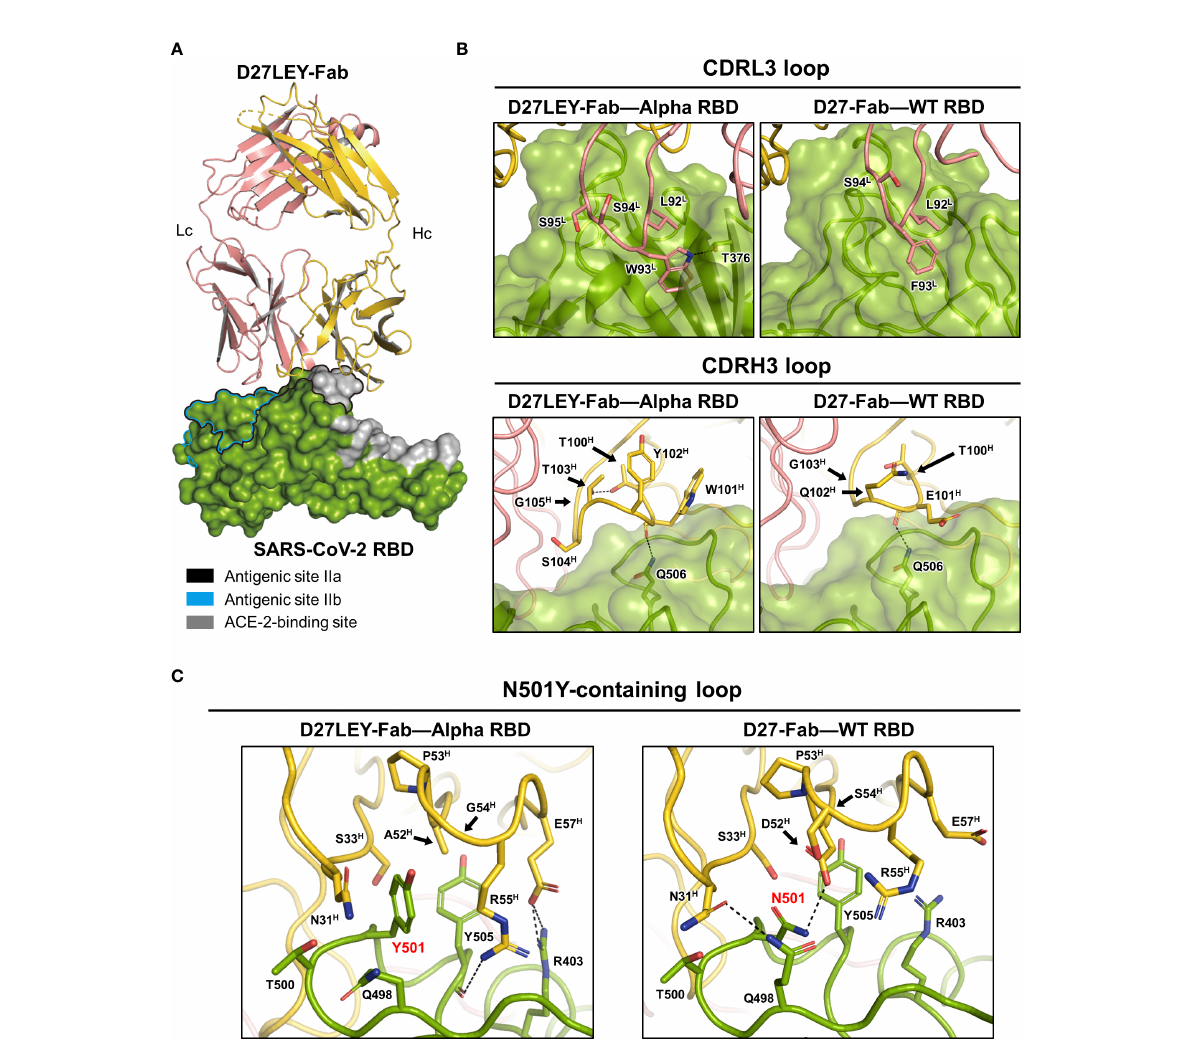
FIGURE 2 Crystal structure of D27LEY-Fab – Alpha RBD in comparison with D27-Fab – WT RBD. (A) Overall view. The RBD-binding interface of D27LEY slightly overlaps with the RBM and largely with the antigenic sites IIa and IIb on the RBD core. (B) Side-by-side views of the interactions between the CDR3 loops and the two antibodies (D27LEY and D27). (C) The interactions of the N501Y mutation site with D27LEY (Left; Y501) and D27 (Right; N501) are shown side-by-side. The black arrows indicate the two substituted amino acids as a result of the computational af fi nity maturation (A52 H and G54 H in D27LEY; D52 H and S54 H in D27). Note that two unchanged residues, R55 H and D57 H , interact with Y501 and Y505 of the RBD in the D27LEY-Fab – Alpha RBD structure. The RBDs in the D27LEY-Fab – Alpha RBD and D27-Fab – WT RBD (PDB entry: 7VYR) were aligned in (B, C)